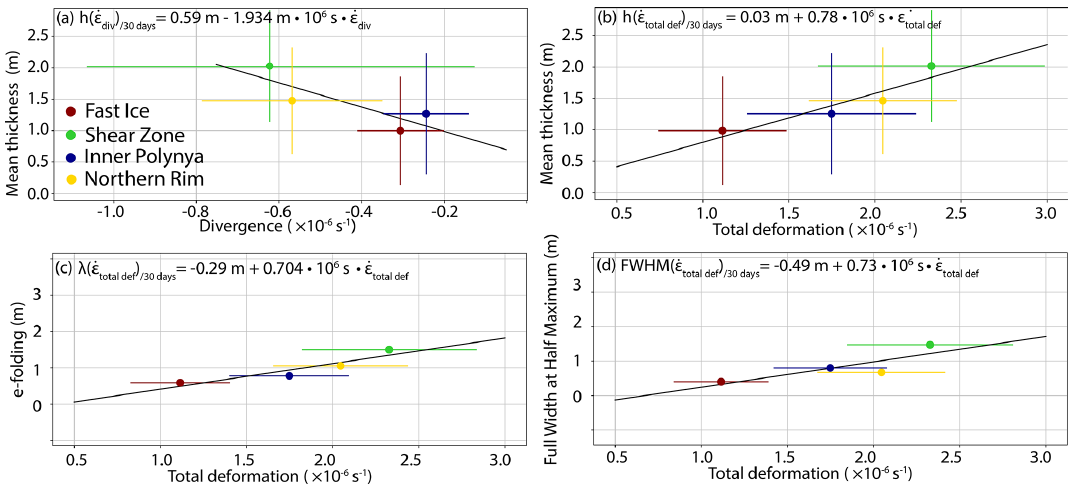
Figure 8. Relationship between mean deformation and ITD key parameters in the four polynya zones. If applicable, standard deviations are displayed as error bars. Thickness and mean deformation are given for 1–31 March. We subtracted the thermodynamic thickness of 0.38m that was reached on 1 March from the mean thickness on 30/31 March. Note that convergence is negative divergence.